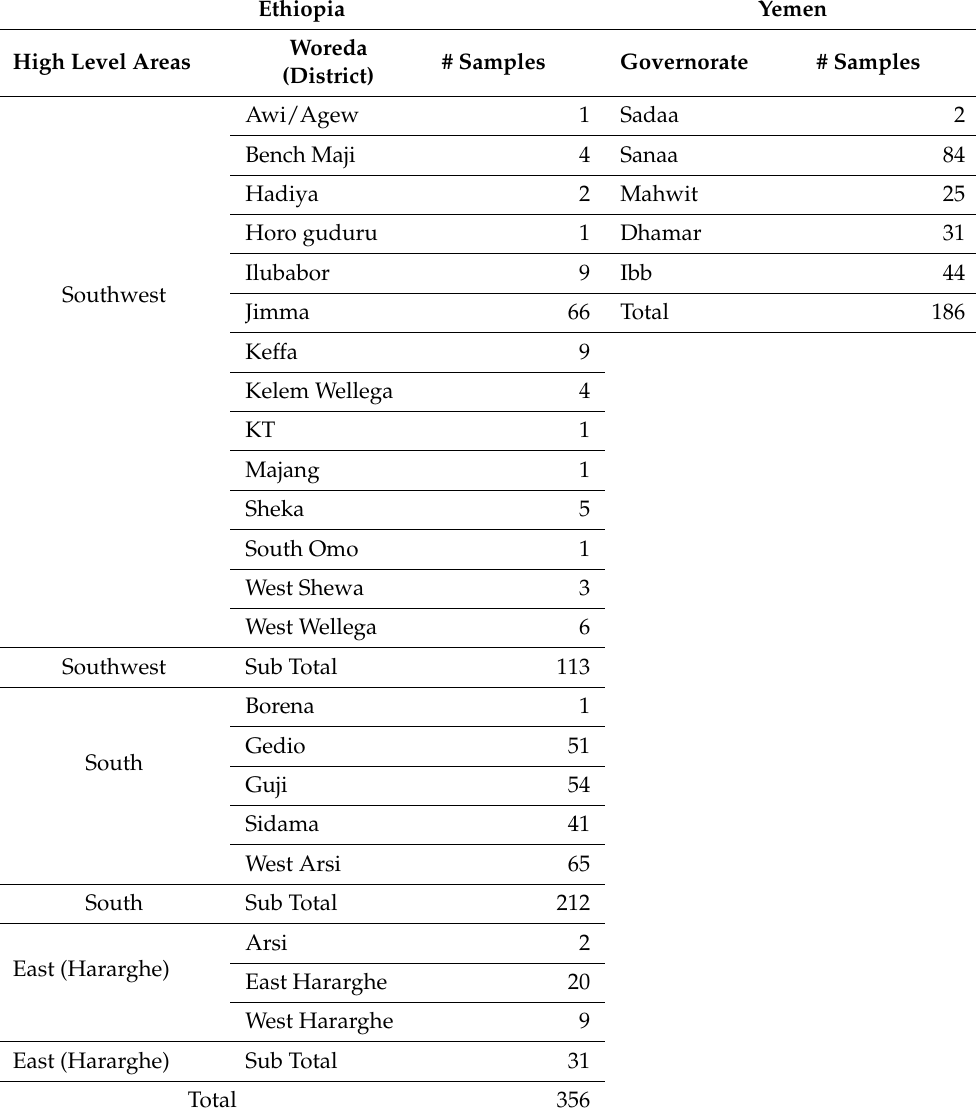
Table 1. Geographical origin of coffee samples from Ethiopia and Yemen included in the study. Ethiopia Yemen Woreda # Samples # High Level Areas (District)